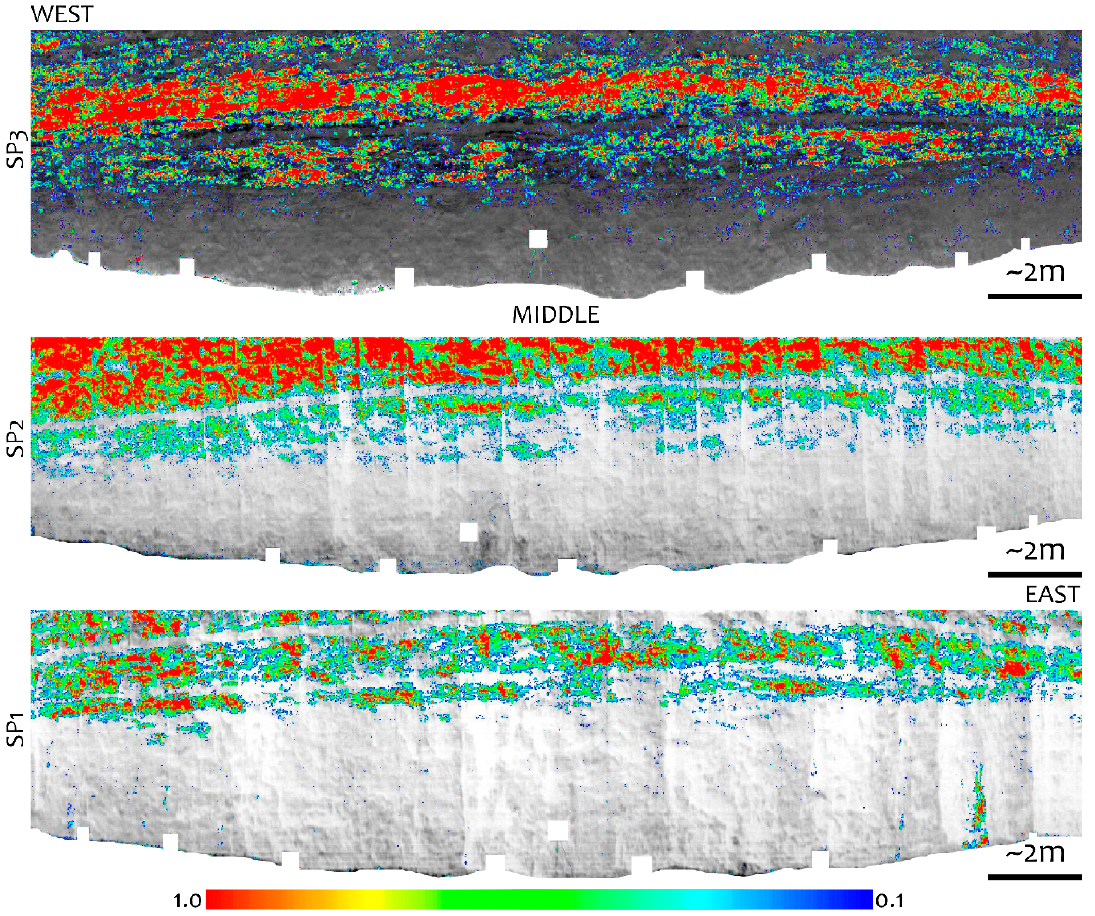
Figure 15. Mixture-tuned match filtering results of tripolite from SP3 to the west to SP1 to the east of the roadcut. The score images were classified between 0.1 and 1.0, with an increment of 0.0625.